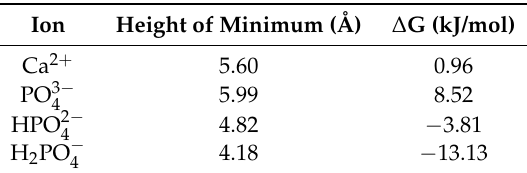
Table 2. Free energies of adsorption for calcium and phosphate ions at the aqueous-brushite {010} interface relative to bulk solution. Heights above the surface are given relative to the first layer of Ca ions. Ion Height of Minimum (Å) ∆ G (kJ/mol)